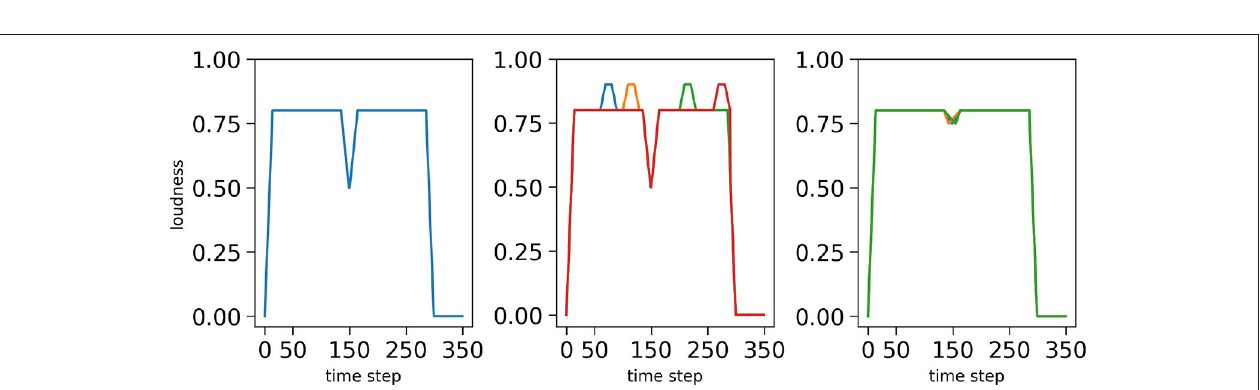
FIGURE 4 | Examples of loudness variations for three input sequences: the word “ a ” (left) , the word “ pata ” (middle) and the word “ apata ” (right) . Simulated time is on the x -axes, normalized loudness (arbitrary units) is on the y -axes. The vertical bars and top annotations refer to the associated phonetic content of the stimulus.